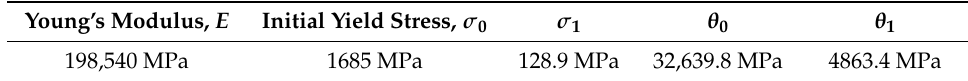
Table 1. Averaged properties of steel 1.1274 obtained from quasi-static tensile tests and values of constants for the extended Voce equation